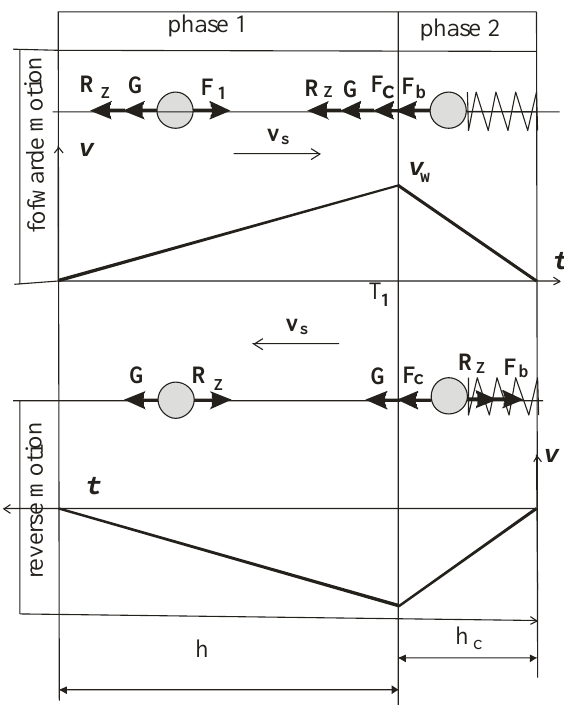
Figure 3. Timing chart of the relocation of the center of mass S relative to the axis O 0